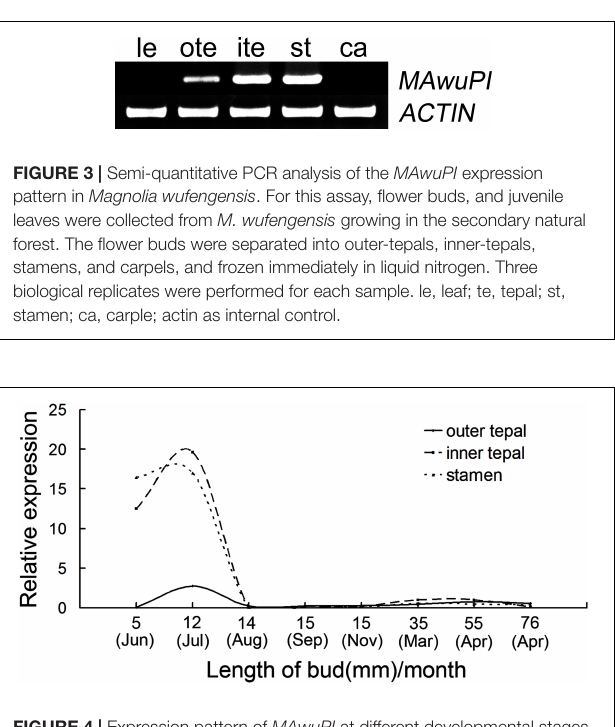
FIGURE 4 | Expression pattern of MAwuPI at different developmental stages. For this assay, plant materials were collected from M. wufengensis growing in the secondary natural forest at different time-point, and frozen immediately in liquid nitrogen. Three biological replicates were performed at each time-point, and at least three technical replicates were performed for each data. Gene expression level was shown as fold changes in comparison to MAwuactin .